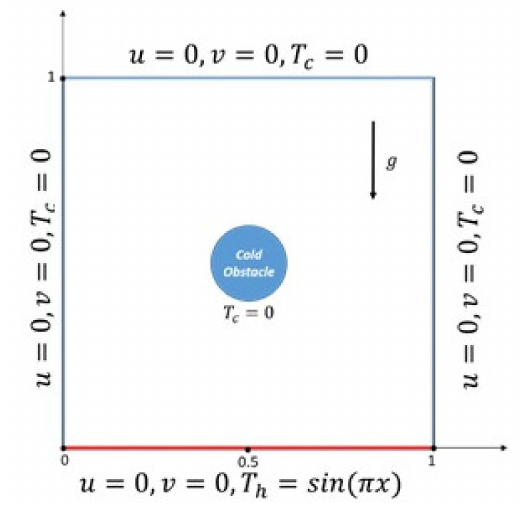
Figure 1. Graphical representation of the